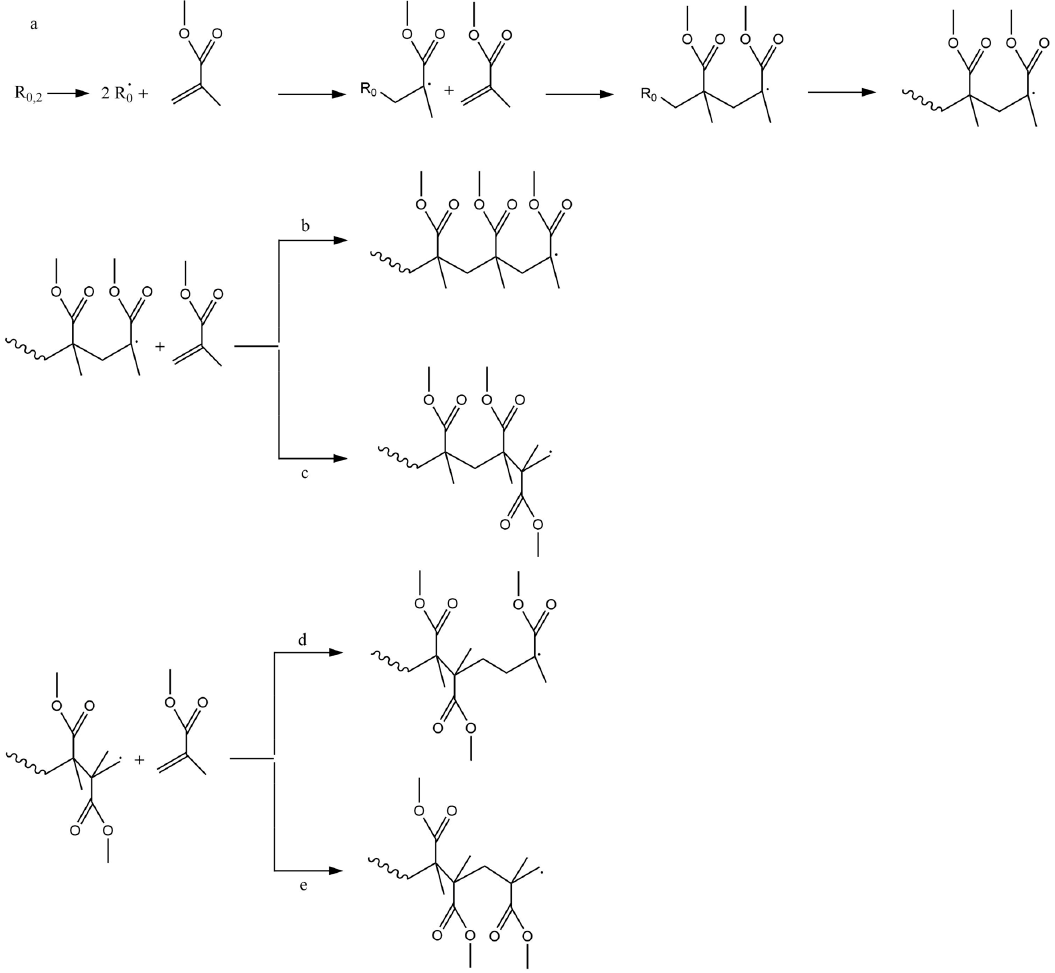
Figure 3. ( a ) Initiator dissociation, chain initiation and propagation as basic reactions in free radical polymerization (FRP) of methyl methacrylate (MMA); ( b ) four types of propagation (addition) for FRP of MMA: head-to-tail (H–T), head-to-head (H–H) ( c ), tail-to-tail (T–T) ( d ) and tail-to-head (T–H) ( e ) addition. H-T is the most common addition so that H-H and T-T linkage or dyads must be seen as structural defects.